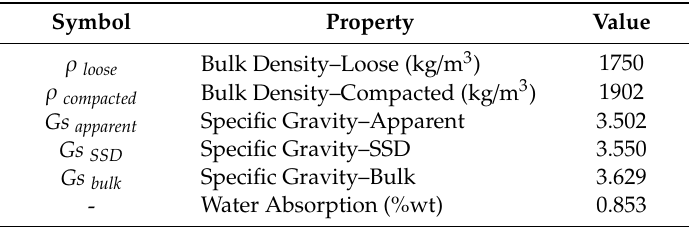
Table 2. Physical properties of Self-consolidating concrete